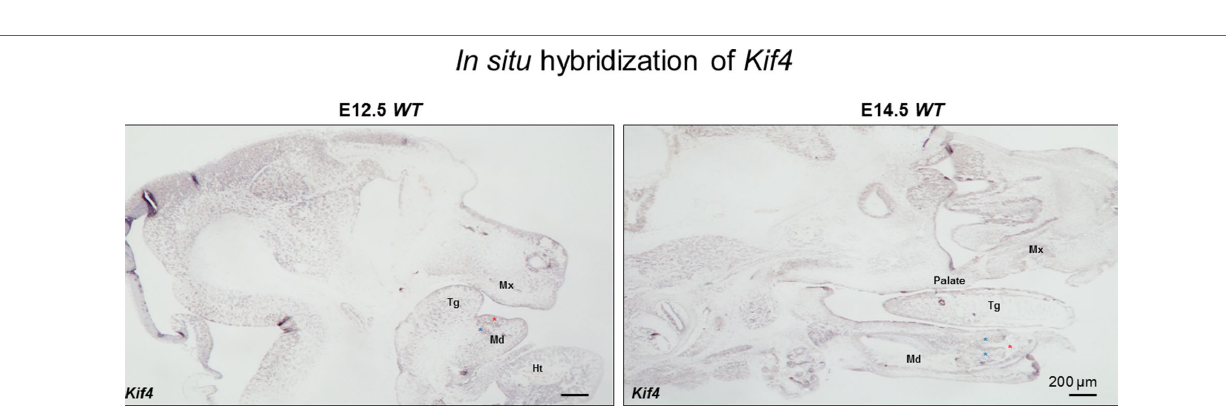
FIGURE 3 | The in situ hybridization of Kif4 in E12.5 and E14.5 embryos. Red asterisks show lower incisors, blue asterisks show mesenchyme adjacent the lower incisors. Tg, tongue; Md, mandible; Mx, maxilla; Ht, heart. Scale bar: 200